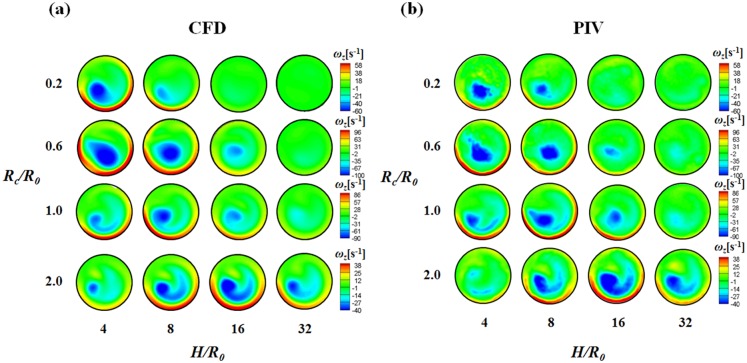
Normal-direction vorticity field contours at the outlet of the helical tubes for a range of helical curvatures and pitches.The results obtained by (a) CFD and (b) PIV are compared at Re = 814.